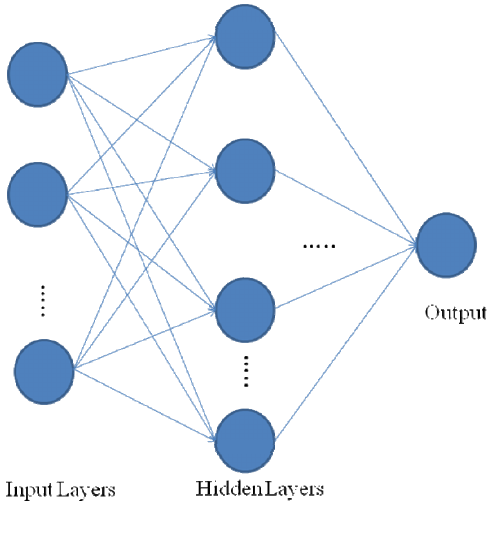
Figure 4. The architecture of a neural